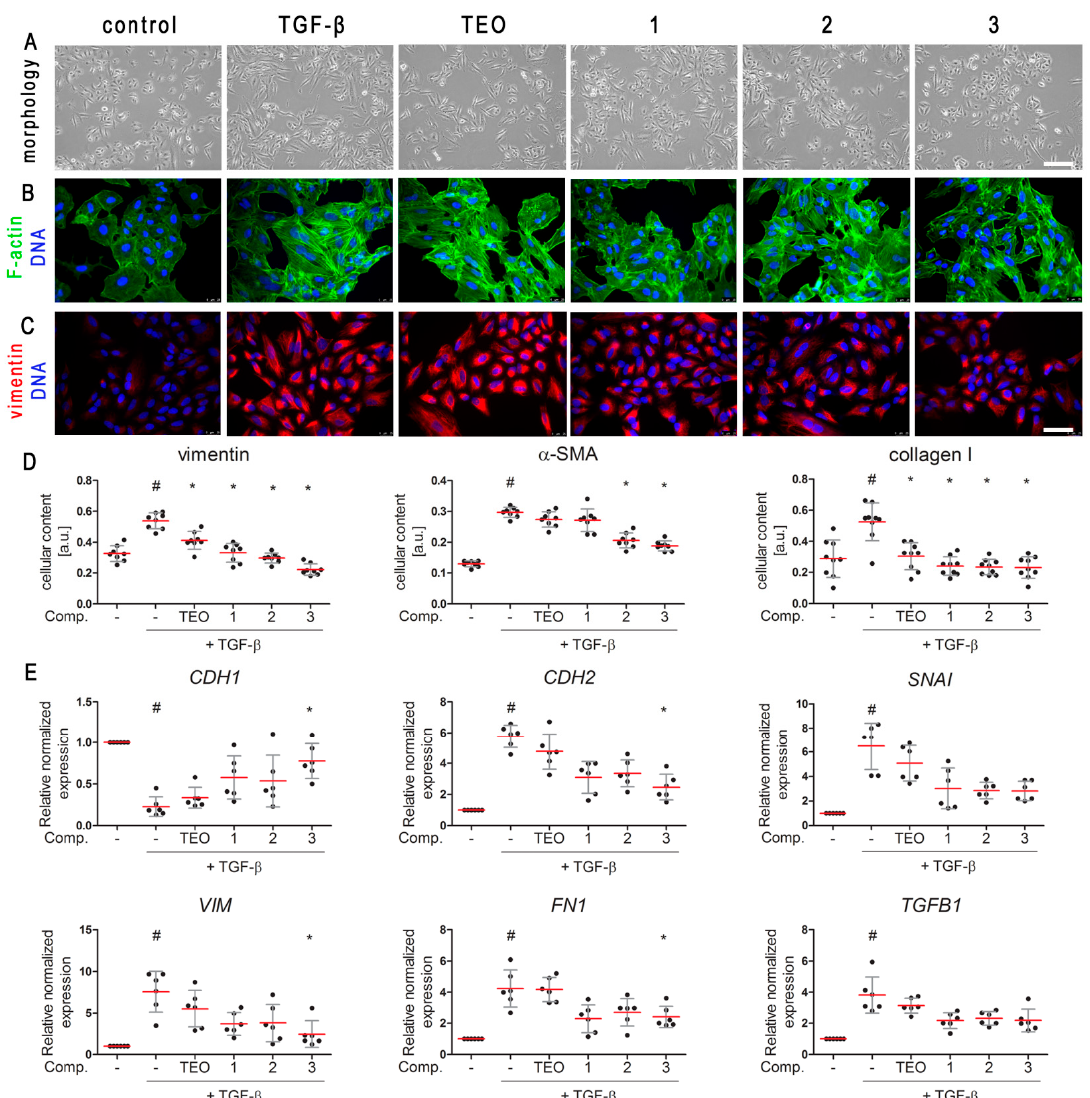
Figure 4. Pan-PDE inhibitors decrease the TGF- β -induced pro-fibrotic phenotype in alveolar epithelial type II cells. A549 cells were cultured overnight and then serum-deprived for 24 h. 1 , 2 , 3 , or TEO (10 µ M) was administrated 1 h before TGF- β (5 ng/mL) treatment for 24 h ( E ) or 48 h ( A – D ) of incubation. ( A ) Representative images (100 × magnification) illustrating TGF- β -induced A549 morphology in the presence of the tested compounds. Scale bar = 200 µ m. ( C , B ) Representative images (400 × magnification) of A549 cells stained for F-actin and nuclei ( B ) and immunostained for vimentin and nuclei ( C ). Cells were fixed, permeabilized, blocked, and incubated with anti-vimentin antibody followed by an Alexa Fluor 546 conjugated antibody or TRITC-labeled phalloidin, and nuclei were co-stained with Hoechst 33342 dye. Scale bar = 50 µ m. ( D ) Cellular content of vimentin, α -SMA, and collagen type I was determined by in-cell ELISA. Horizontal lines represent the mean value ( ± SD), n = 8 (ANOVA with Dunnett’s post-hoc test). ( E ) Relative, normalized to 18S rRNA level, expression of CDH1 , CDH2 , SNAI , VIM , FN1 , and TGFB1 was carried out by RT-qPCR analysis. Horizontal lines represent the median with interquartile range, n = 6 (Kruskal–Wallis test with Dunn’s post-hoc test). The results were considered statistically significant at the p -level of 0.05, compared to basal control (#) and TGF- β (*)